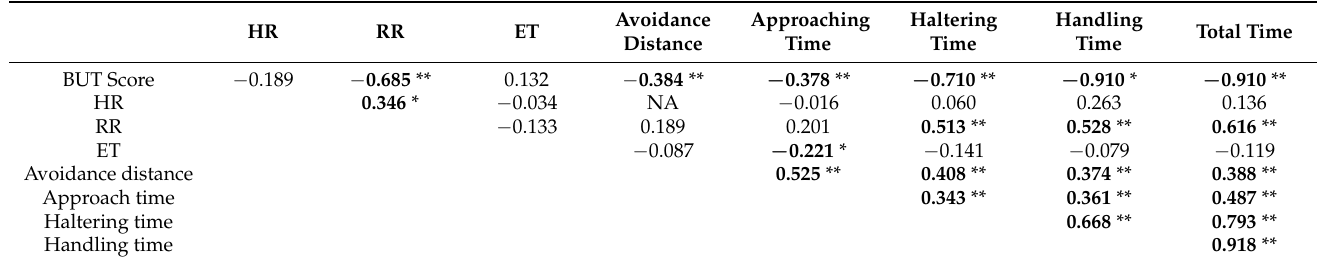
HR = heart rate, RR = respiratory rate, ET = eye temperature. NA = not applicable as HR was only assessed when avoidance distance was 0. Bold values denote statistical significance at the p < 0.05 level: ** Correlation is significant at the 0.01 level (2-tailed), * Correlation is significant at the 0.05 level (2-tailed).